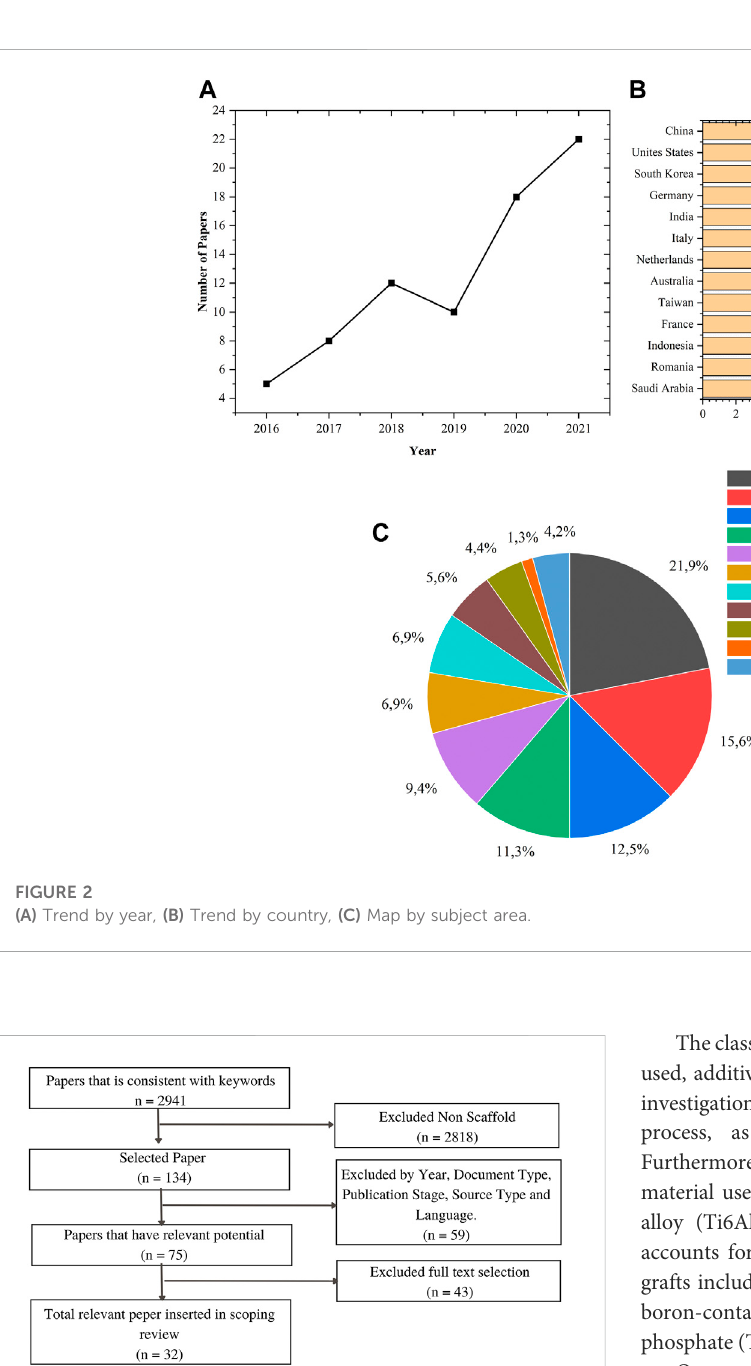
FIGURE 3 Flowchart article process